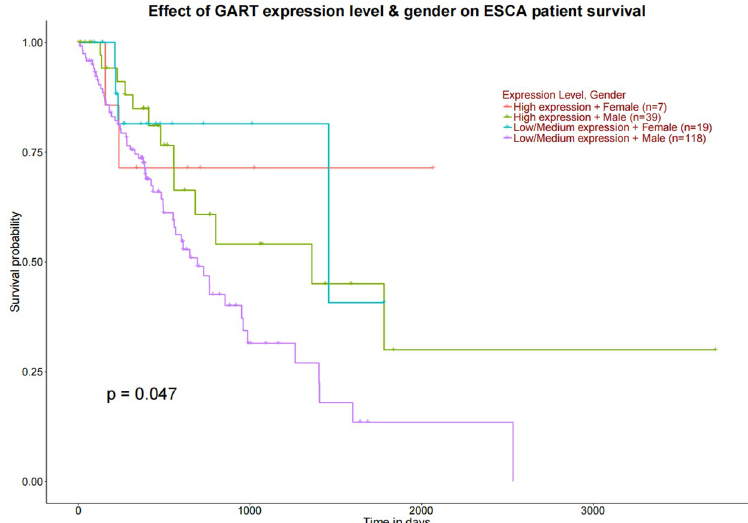
Fig 10. Combined the expression of mRNA or miRNA with gender, GART was correlated to overall survival (OS) in EAC patients.